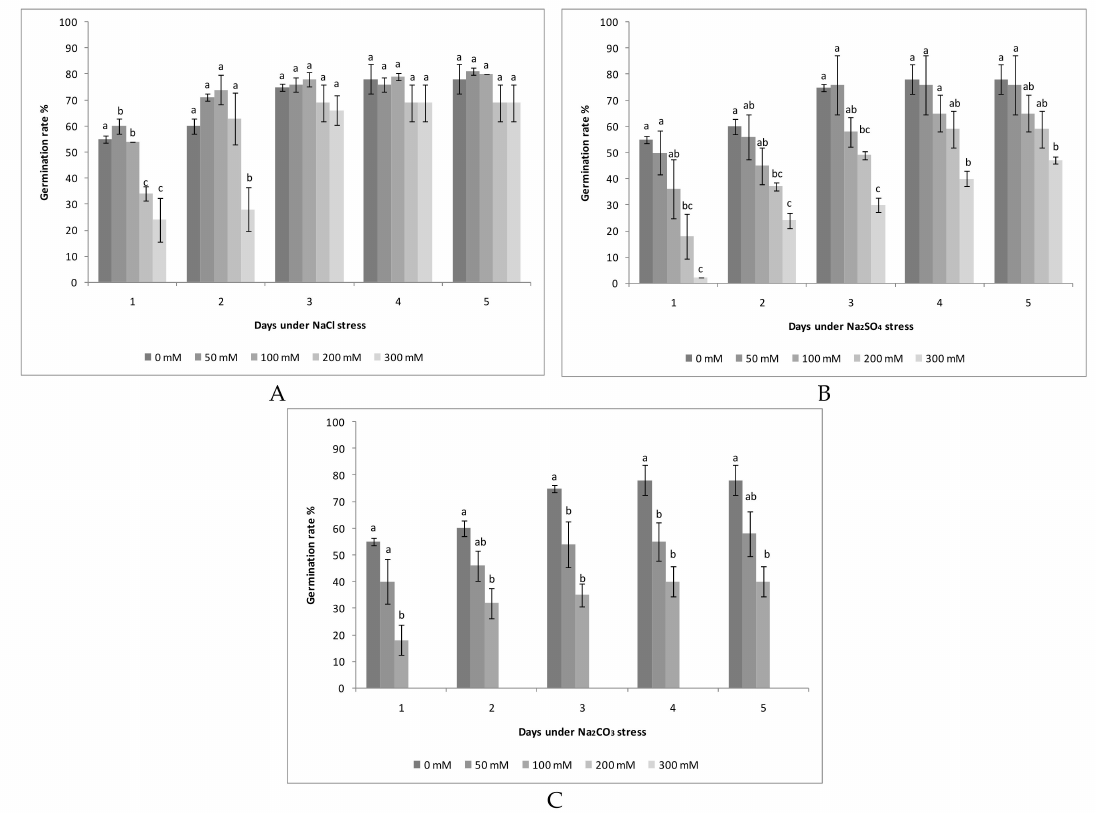
Figure 3. Seed germination rate of Vikinga cultivar under NaCl ( A ), Na 2 SO 4 ( B ) and Na 2 CO 3 ( C ) stresses. Di ff erent letter means significant di ff erences, according to Tukey test. Error bars indicate mean ±